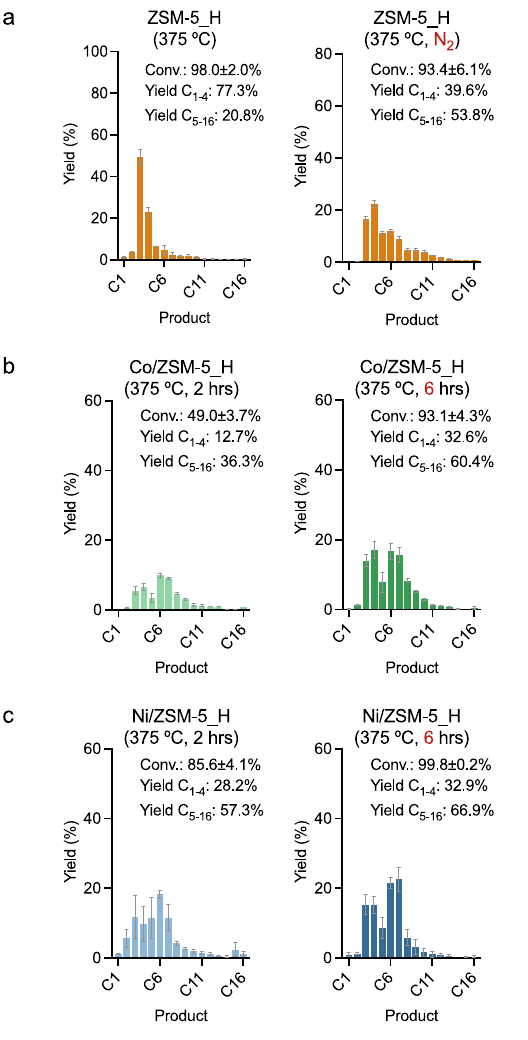
Fig. 3 | Product distributions and appearances of liquid products after n- hex- adecane (nC 16 ) deconstruction. a nC 16 (1.59g, 7.0mmol) deconstruction using ZSM-5_H (0.1g) under hydrogen and under nitrogen, pressure=45 bar, 2h. b nC 16 (1.59g,7.0mmol)deconstructionusingCo/ZSM-5_H(0.1g,metalloading=2.5wt%), 45 bar H 2 for 2 and 6h. c nC 16 (1.59g, 7.0mmol) deconstruction using Ni/ZSM-5_H (0.1g,metalloading=2.5wt%),45barH 2 for2and6h. d Coloroftheresultingliquid